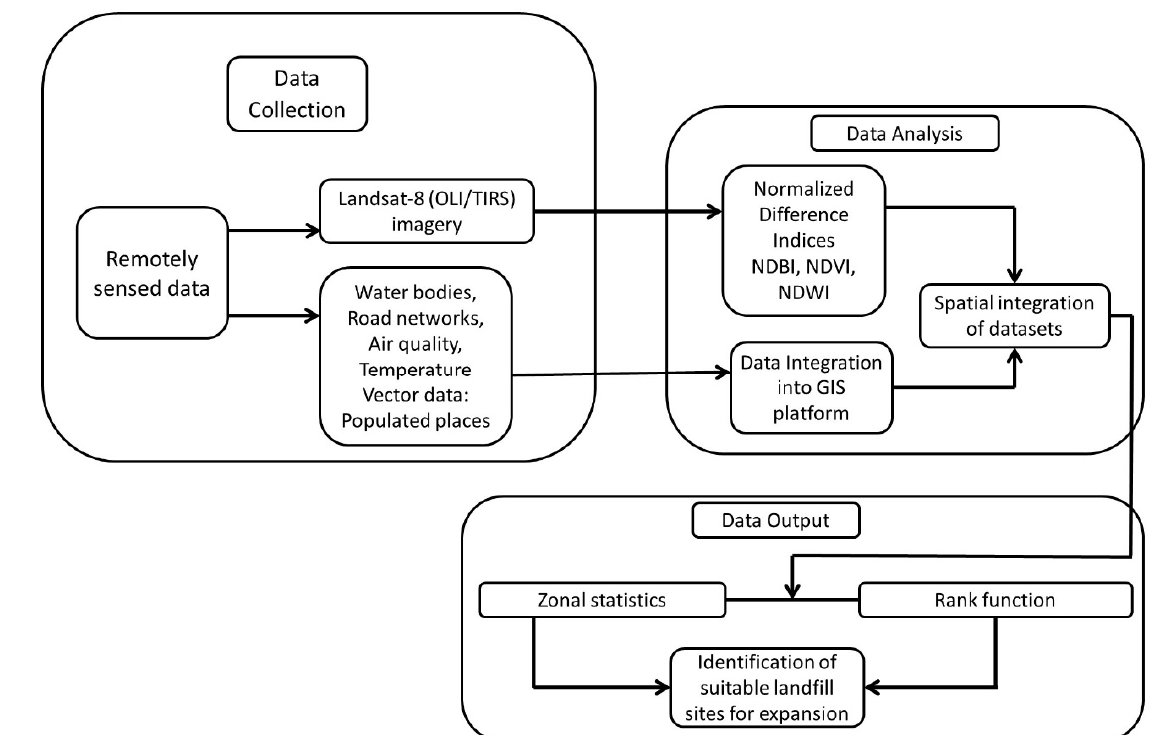
Figure 2. Workflow for landfill site assessment.